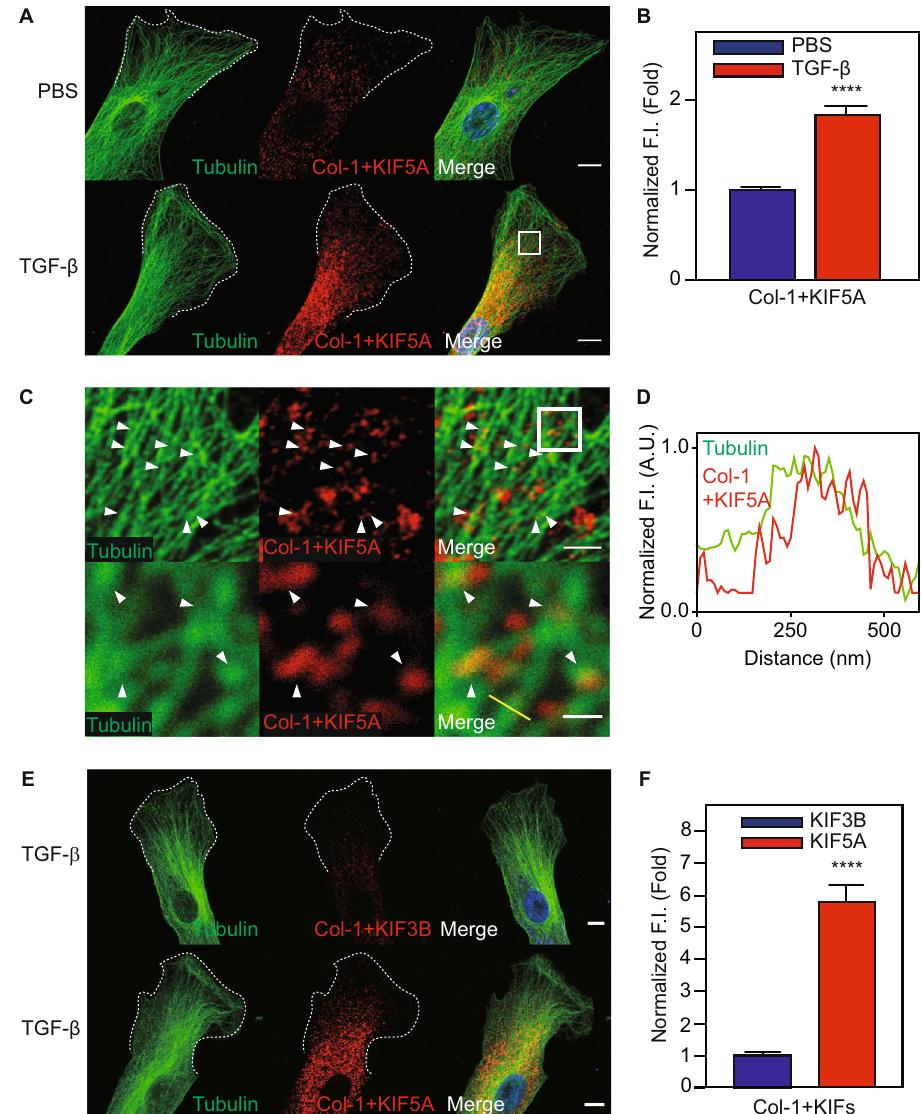
Figure 3. Proximity-ligation assay for colocalization of KIF5A and Col-1 in HPMC. ( A ) Confocal images of single HPMCs with proximity-ligation assay with or without TGF- β stimulation. Merge images include blue nucleus signal. White dotted lines indicate the edge of cells. Scale bar; 10 μ m. ( B ) Quantitative analysis of average fluorescent intensity inside the cells of A (n = 6 cells). **** P < 0.0001 vs basal level. F.I., Fluorescent Intensity. ( C ) Magnified images of intracellular structures. White box in A was magnified. White box in upper image was magnified to lower images. White arrows indicate colocalization among Col-1 and KIF5A and tubulin. Scale bar; 2 μ m in upper image, 0.5 μ m in lower image. ( D ) Quantitative line profile of co-localization along the yellow line of C. F.I., Fluorescent Intensity. ( E ) Confocal images of single HPMCs with proximity- ligation assay of KIF3B or KIF5A and Col-1 with TGF- β stimulation. Merge images include blue nucleus signal. White dotted lines indicate the edge of cells. Scale bar; 10 μ m. ( F ) Quantitative analysis of average fluorescent intensity of proximity-ligation signal inside the cells of E (n = 10 cells). Fluorescent intensity of KIF3B and Col-1 was taken as 1. **** P < 0.0001 vs basal level. F.I., Fluorescent